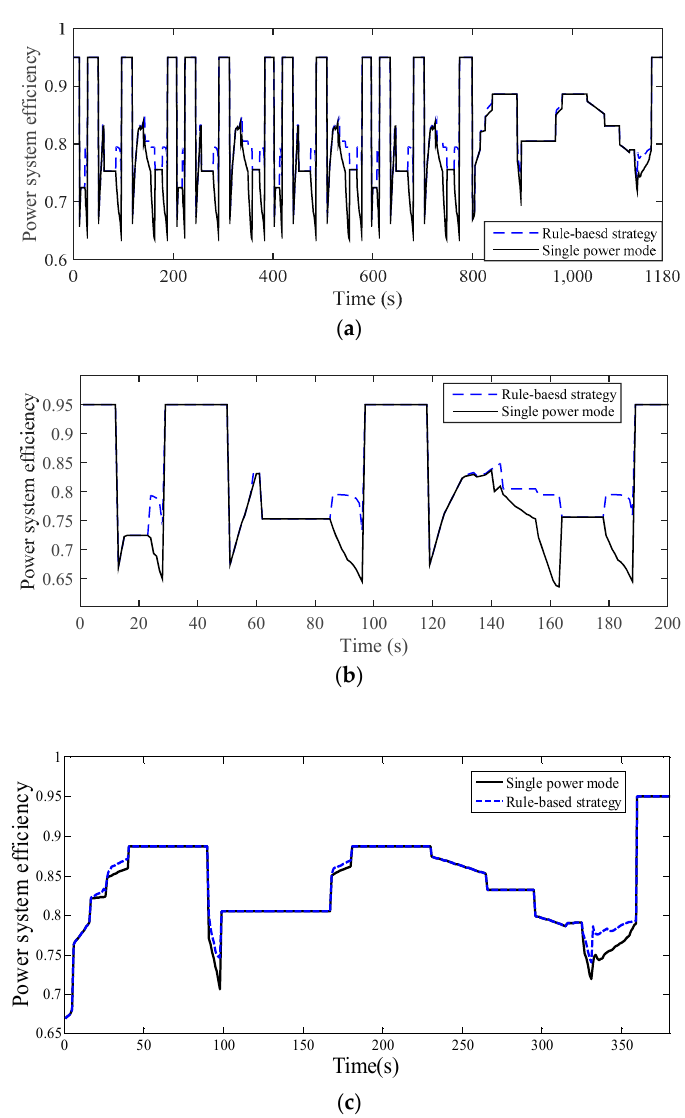
Figure14. Comparison of power system efficiency along NEDC. 331 Figure 14. Comparison of power system efficiency along NEDC. ( a ) Power system efficiency along New European Driving Cycle (NEDC); ( b ) Power system efficiency along an urban driving cycle; ( c ) Power system efficiency along a suburban driving